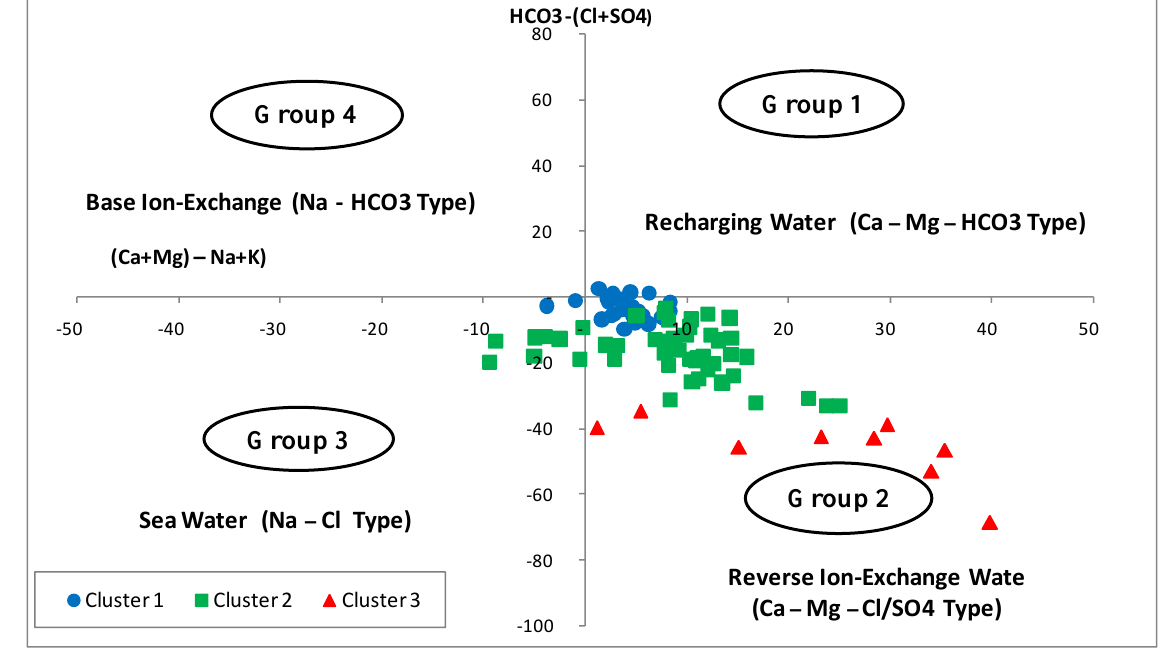
Figure 6. Chadha’s diagram for three clusters.